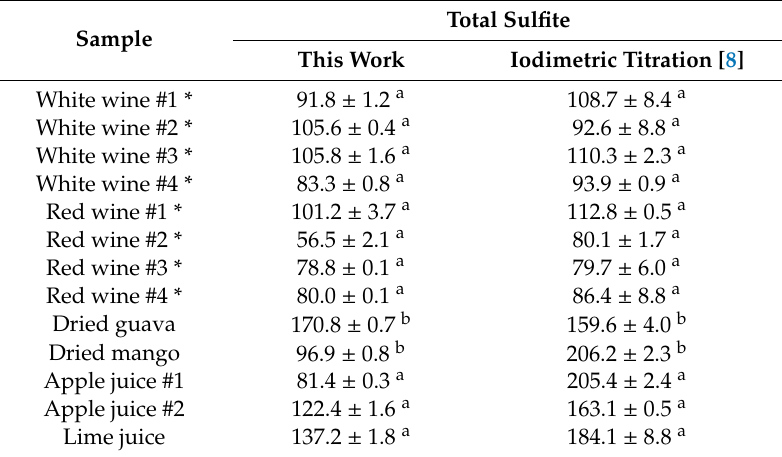
Table 4. Results of total sulfite content in wines, dried fruits and fruit juices determined by FIA-GD-C4D as compared to iodimetric